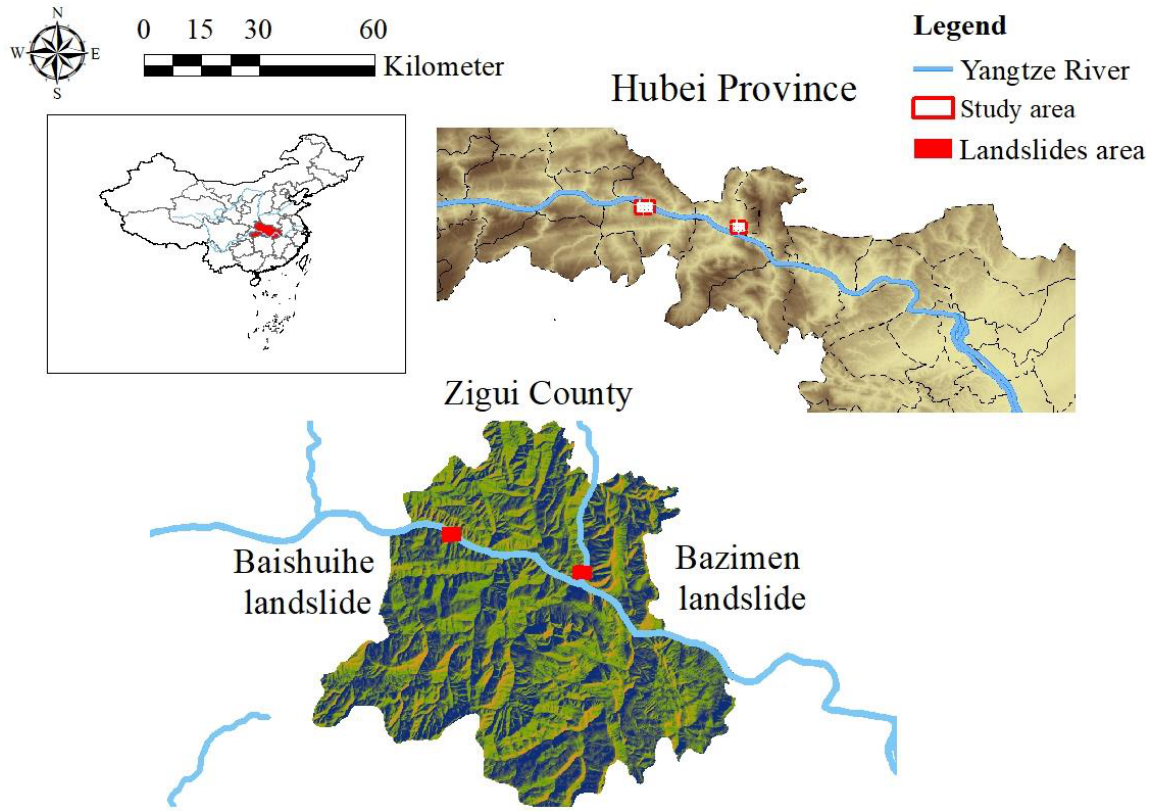
Figure 7. Location map of the study area.